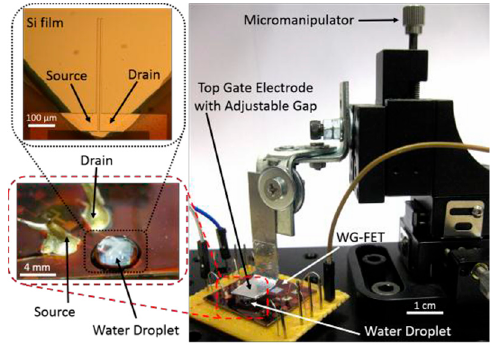
Figure 3. WG-FET under test with a parallel plate top gate electrode with adjustable gap.